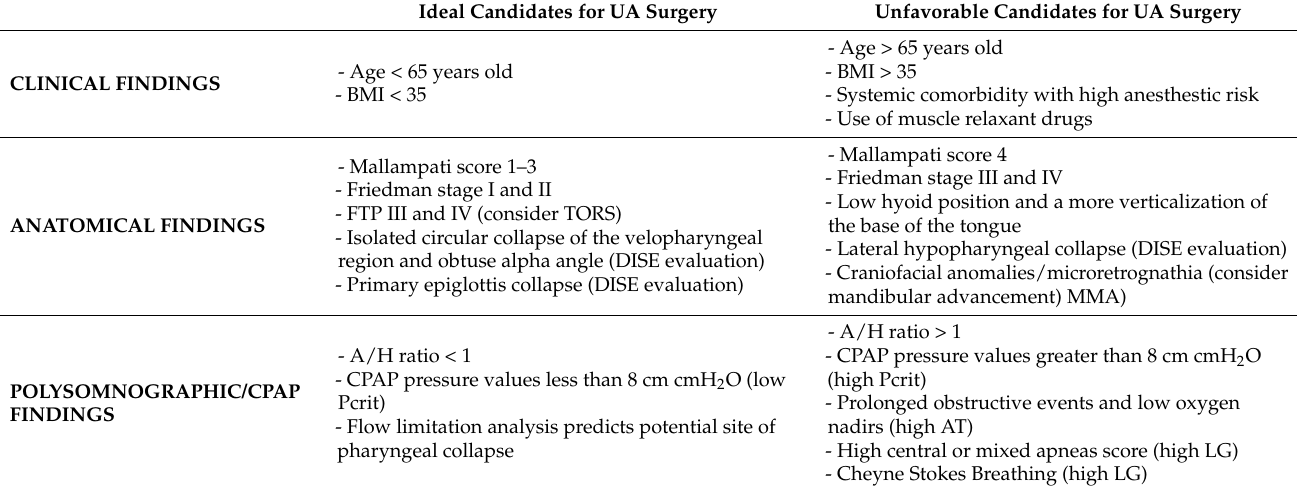
Table 4. Ideal/non-ideal candidates for UA surgery by the analysis of medical history, clinical features, and basic examina- tion